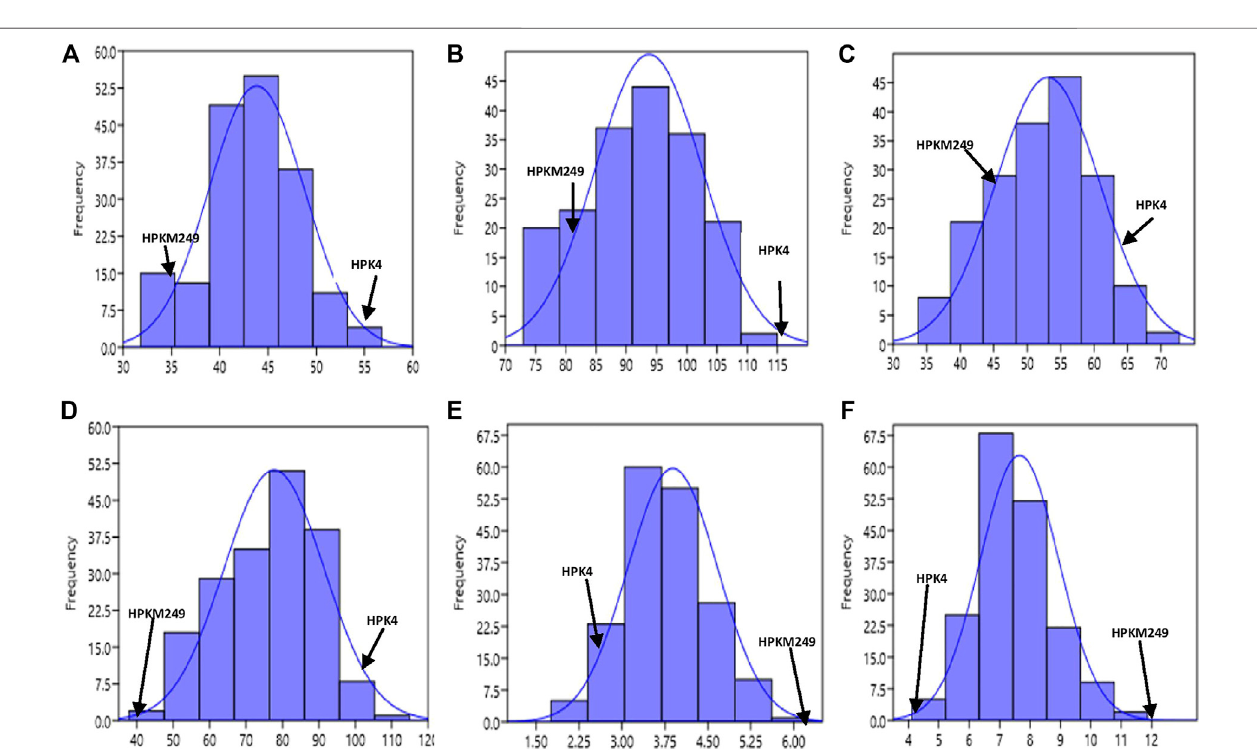
FIGURE2| Frequencydistributioncurveof (A) Daysto50% fl owering (B) Daystomaturity (C) Reproductiveperiod (D) Plantheight (E) No.ofprimarybranches (F) No. of secondary branches.